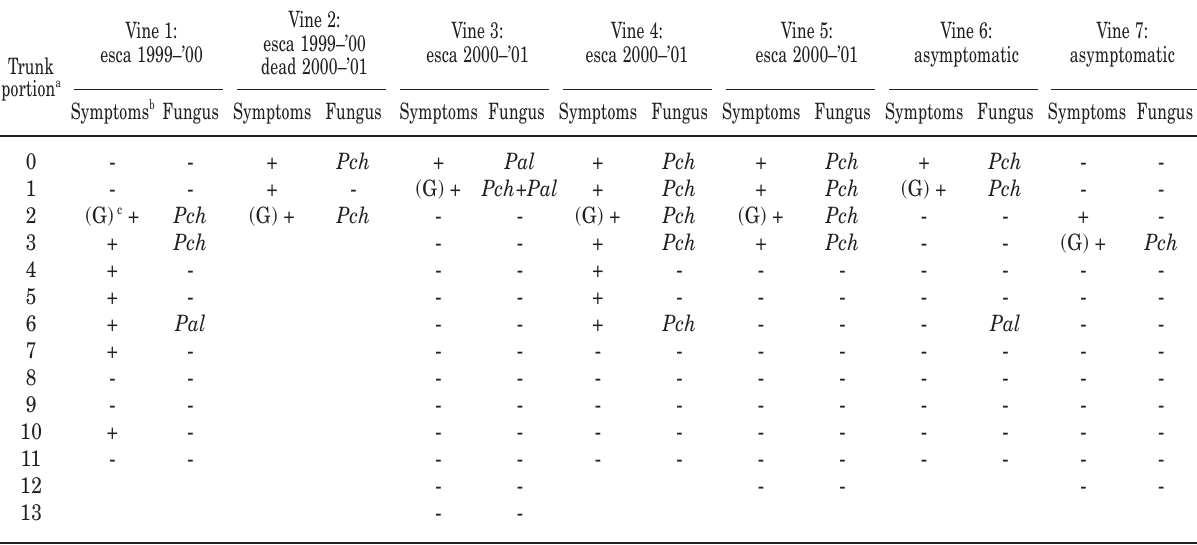
Table 2. Internal symptoms and esca-associated fungi ( Phaeomoniella chlamydospora, Pch; Phaeoacremonium aleo- philum, Pal ) found in the trunks of 4-year-old Merlot vines on Kober 5BB rootstock, from site 2, Wentworth, New South Wales, Australia.